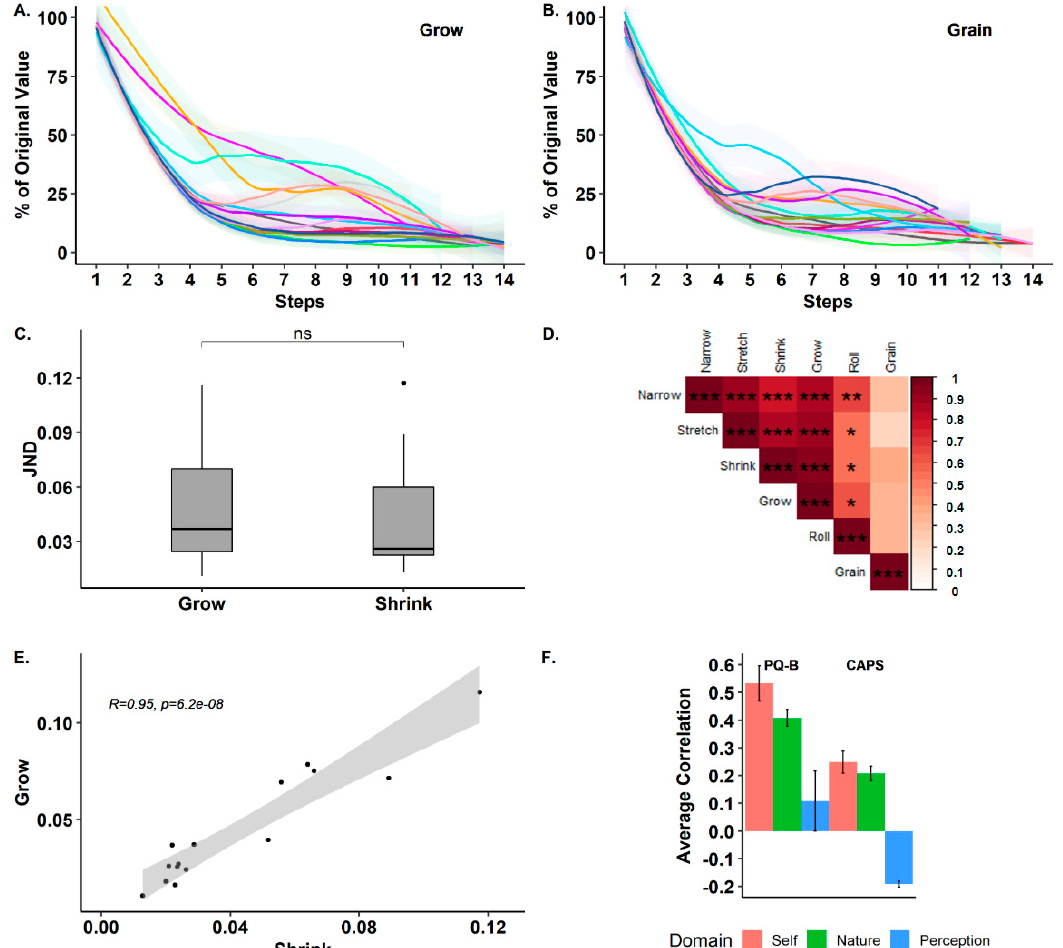
Figure 2. Perceptual thresholds for reality alterations. ( A , B ). Convergence rates of the staircase procedure in aspects grow and grain , respectively. Y -axis shows the magnitude of the reality alteration and the x -axis denotes the number of iterations. Note individual participants (colored lines) converged towards a stable perceptual threshold. ( C ) A comparison between JNDs of grow and shrink aspects that shared a common scale. ( D ) Pearson correlation matrix between JNDs across all aspects. Note high, positive, and significant correlations were found between all aspects’ JNDs, with the exception of grain . ( E ) Example of correlation between participants’ grow and shrink JNDs. ( F ). Averaged correlations of The Cardiff Anomalous Perceptions Scale (CAPS) and the Prodromal Questionnaire Brief Version (PQ-B) scores with JNDs shown by aspect domains (i.e., self, nature, perception).